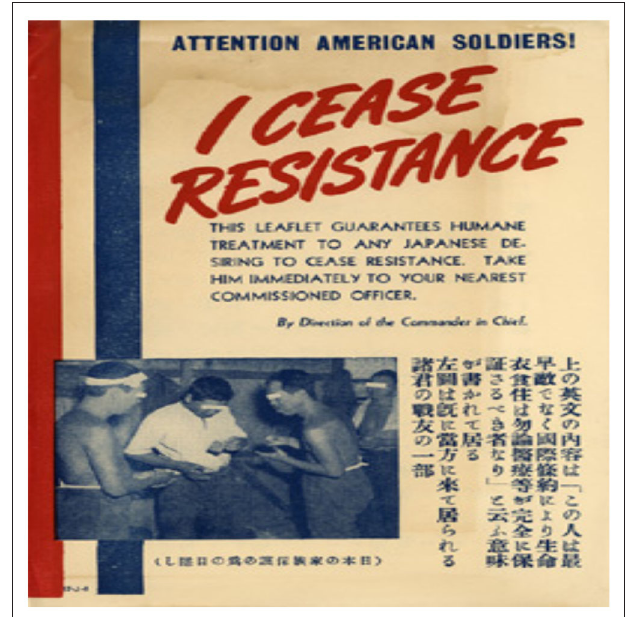
FIGURE 5 | PsyWar Leaflet Archive - 141-J-1 (2012).